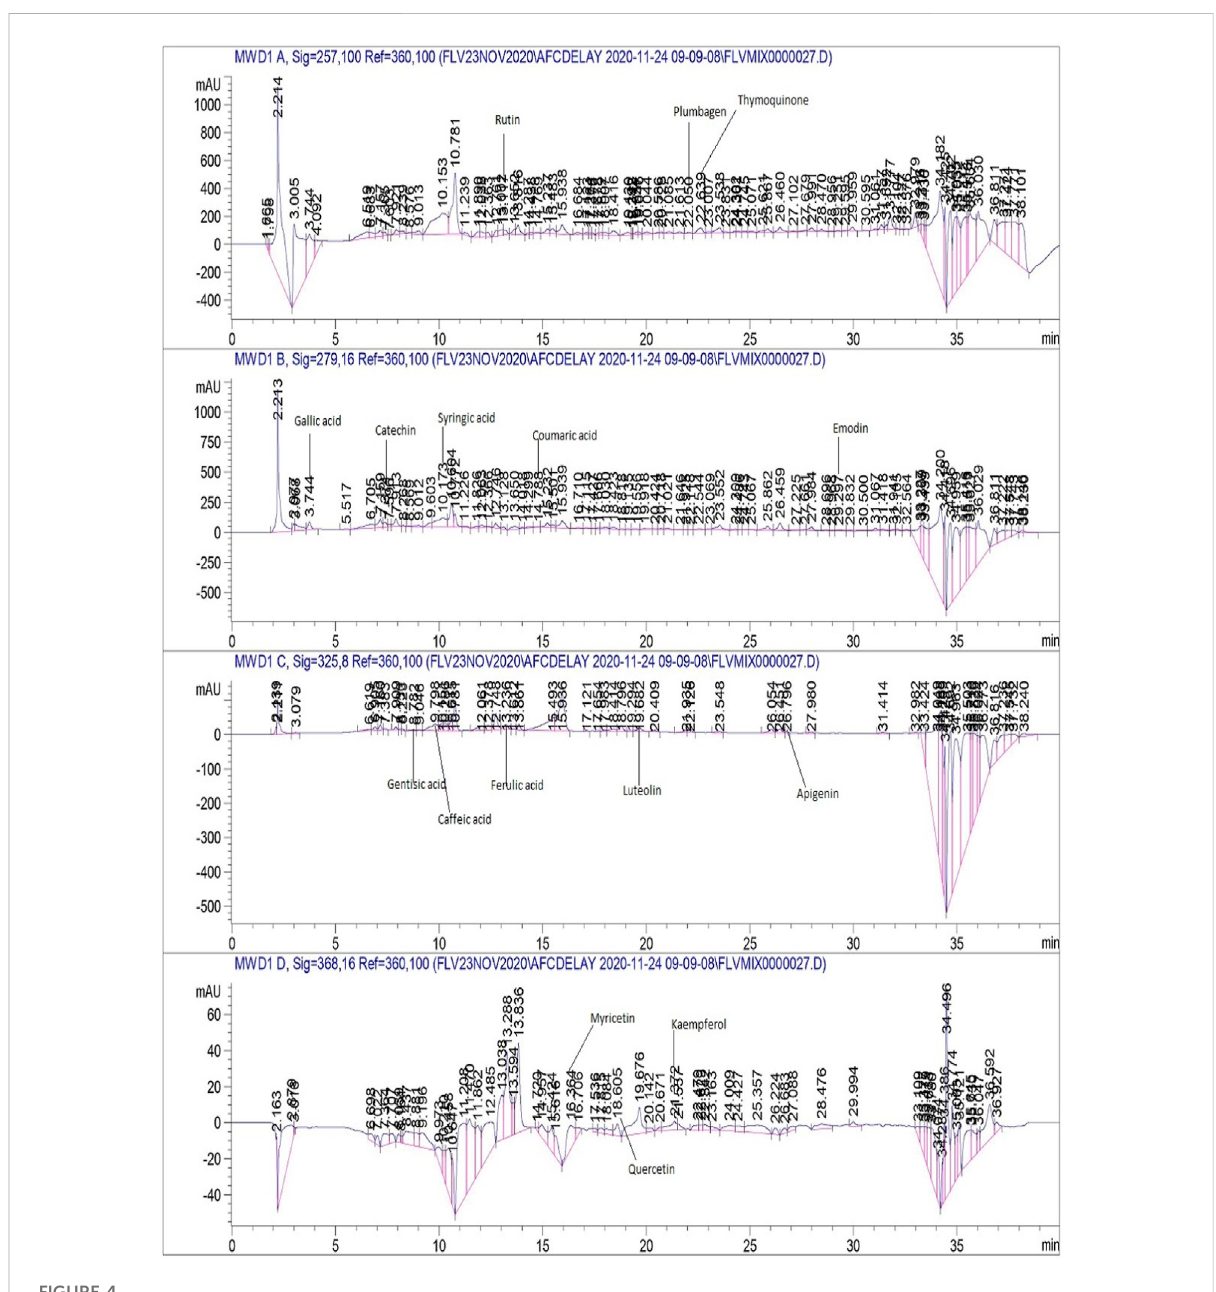
FIGURE 4 HPLC chromatogram of L. inermis M